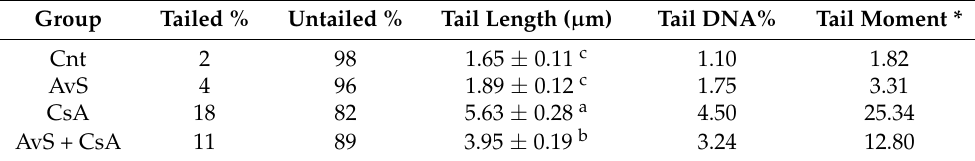
Table 8. Effects of AvS powder on DNA damage, as detected by comet assay in rat kidneys. Group Tailed